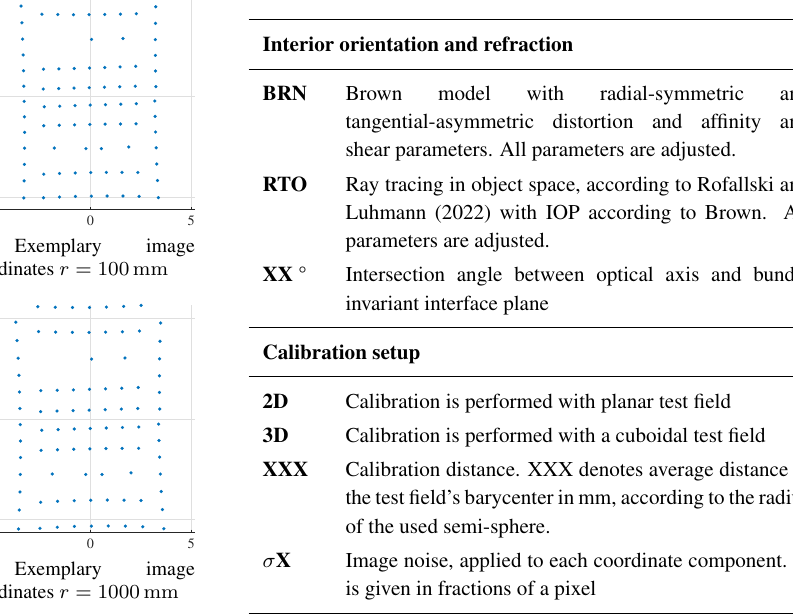
Figure 2. Examples of the bundle geometry and exemplary image coordinates for two different scaling radii r (all units are mm). Mind the disappearing points in the top part in (d).